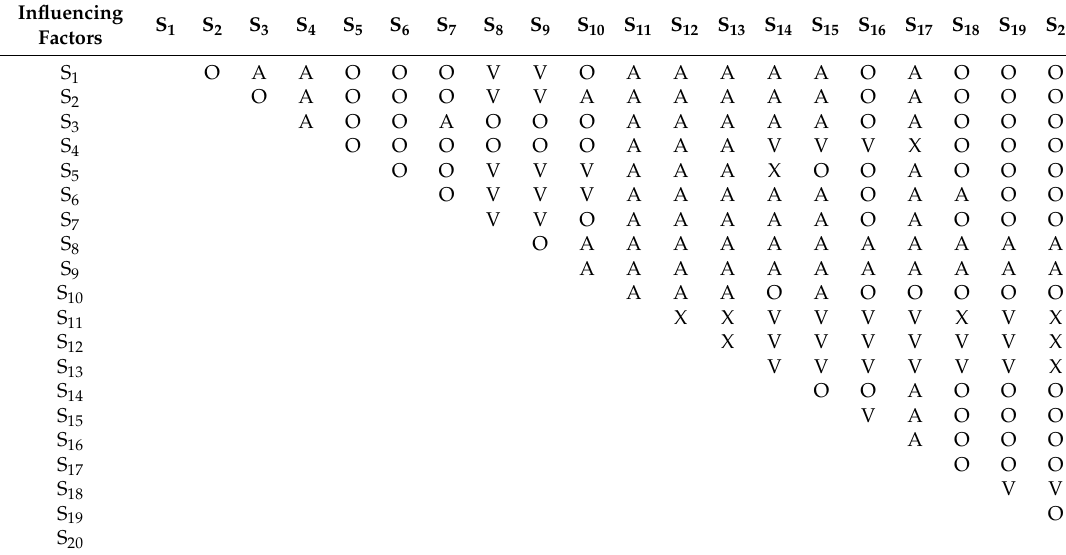
Table 3. Mutual influences of various